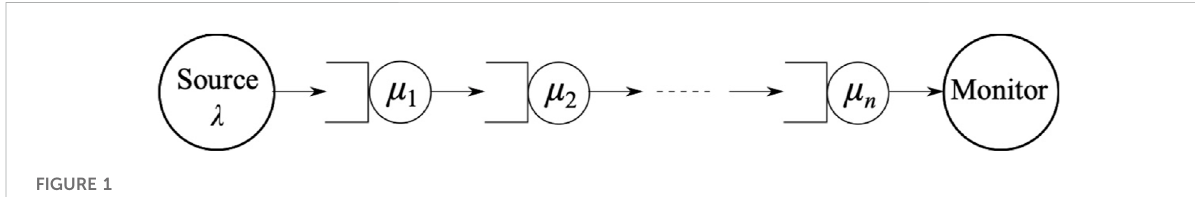
FIGURE 1 Queues in tandem.